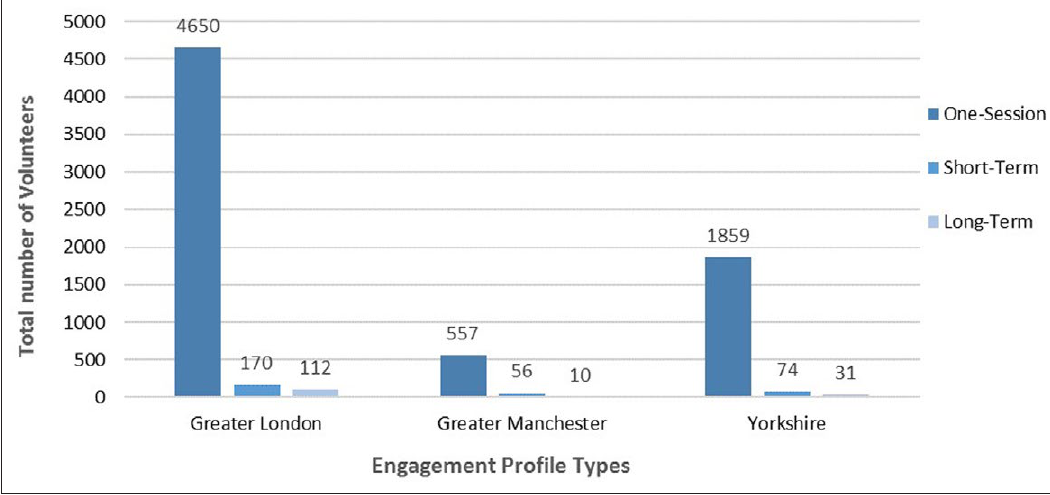
Figure 4: Total numbers of volunteers who contribute to each engagement profile type across